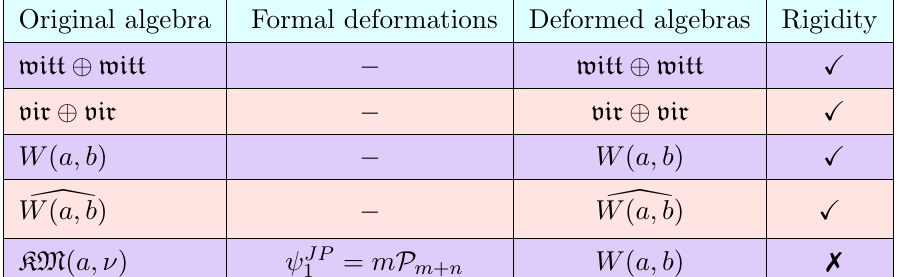
Table 2 . Rigidity of the algebras appearing as formal deformations of algebras in table 1. We note \ that here by W ( a; b ) or W ( a; b ) algebra we mean family of W -algebras with generic values of the a; b parameters. Deformations can move us within this family on the a; b plane. For speci(cid:12)c points ( a = 0 ; b = 0) or ( a = 0 ; b = (cid:0) 1) which are respectively corresponding to KM algebra admits non-trivial